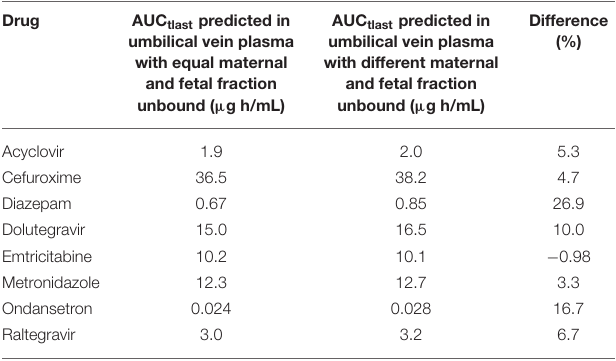
AUC tlast , area under the concentration-time curve from time zero (or, in case of multiple dose studies, time of last dose administration) to the time of the last observed concentration.